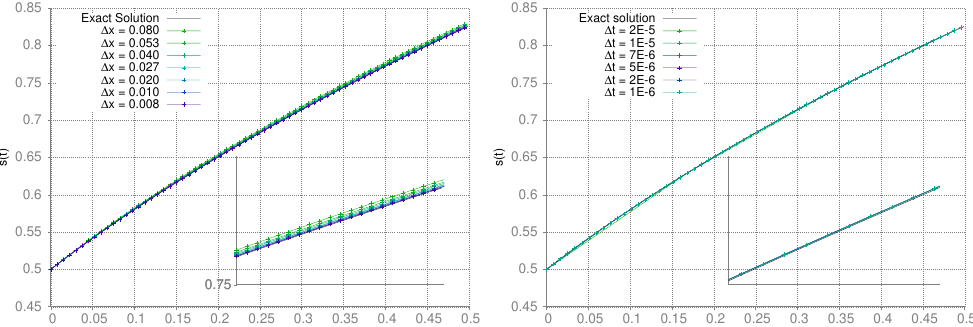
Figure 5. ( Left ): Position of the interface s ( t ) as a function of time t for several meshes. ∆ t is fixed at 10 − 4 —( Right ): Idem but for different time steps. ∆ x is fixed to 10 − 2